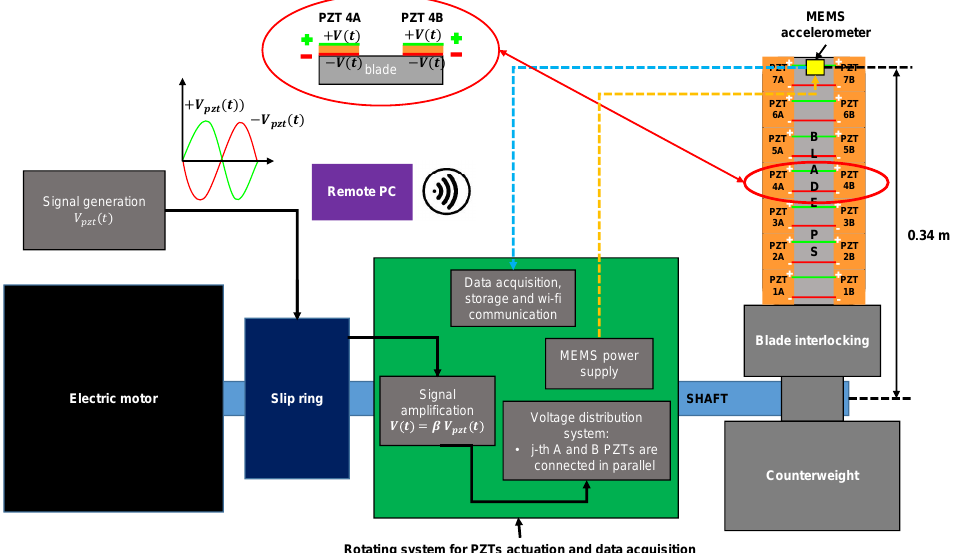
Figure 1. Functional scheme of the wireless vibration monitoring system. The shaft rotating speed is set with an inverter that drives the electric motor. The PZT’s driving voltage V PZT ( t ) is generated by a waveform generator and, by means of a slip ring, is amplified within the rotating system for PZT actuation and data acquisition. The amplification stage provides both V ( t ) and − V ( t ) , which are distributed on each PZT actuator’s pair in order to excite the resonance of the blade. The MEMS accelerometer data were acquired with an on-board data acquisition and storage system that sends data to a remote PC via wi-fi communication. The MEMS accelerometer is battery-powered at 3.6